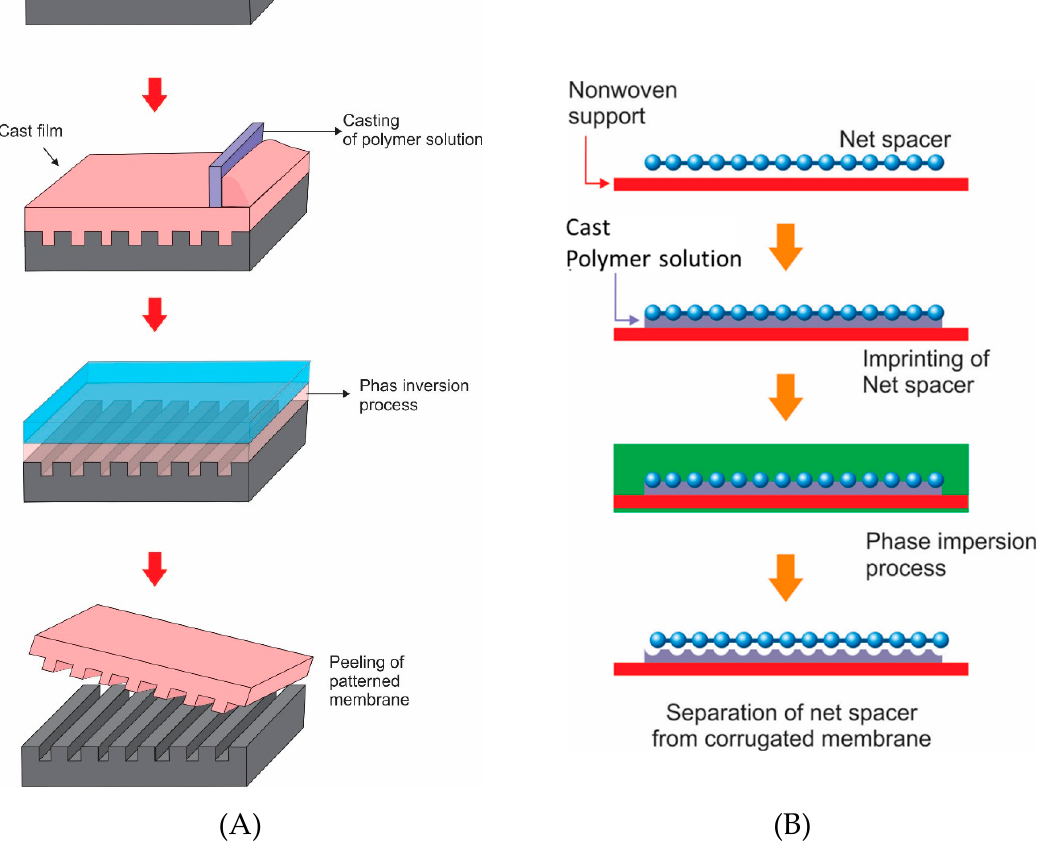
Figure 3. Phase separation micromolding procedures. ( A ) Membrane corrugation formed using a microstructured replica mold. ( B ) Membrane corrugation formed using net spacer.